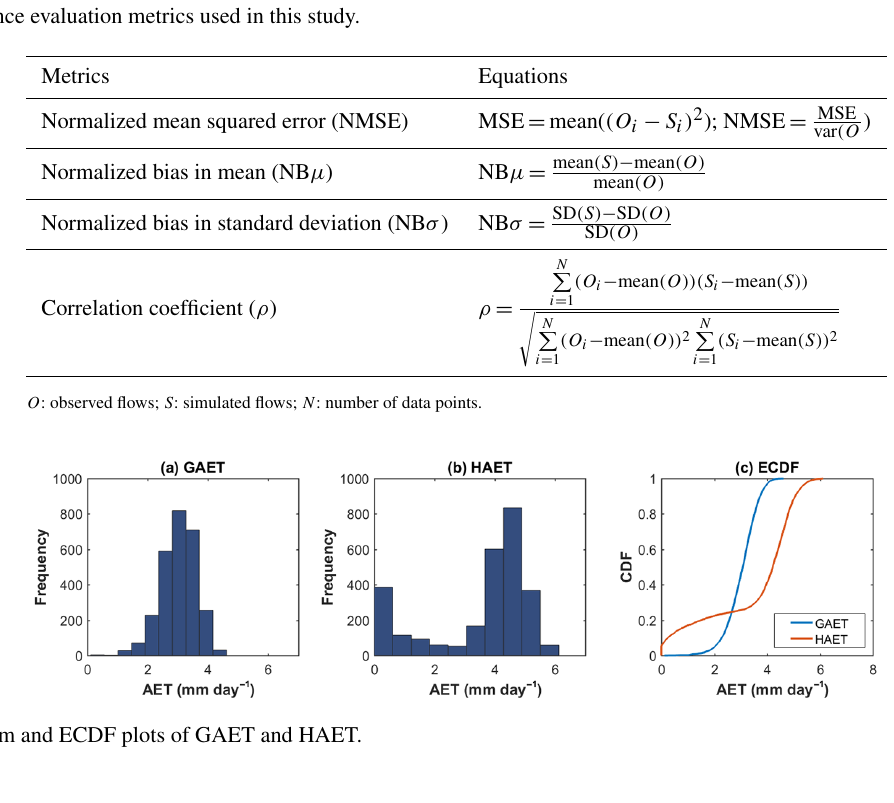
Table 3. Descriptive statistics of GAET and HAET. Table 4. Annual mean of AETs and